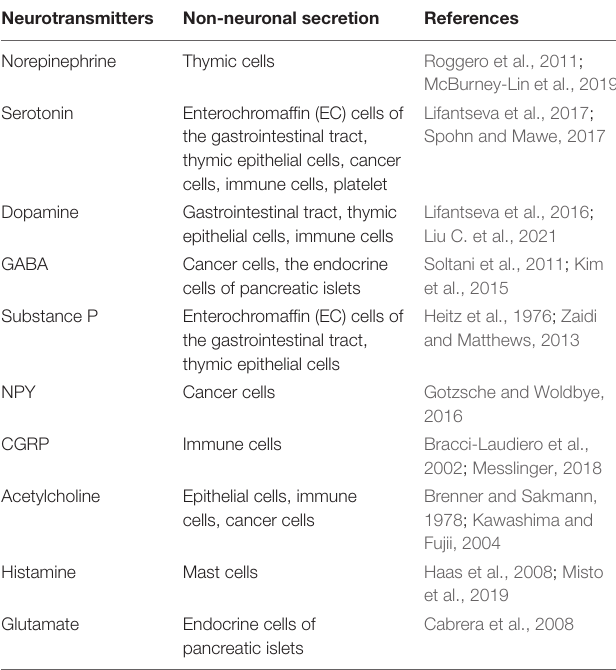
TABLE 1 | The origin of